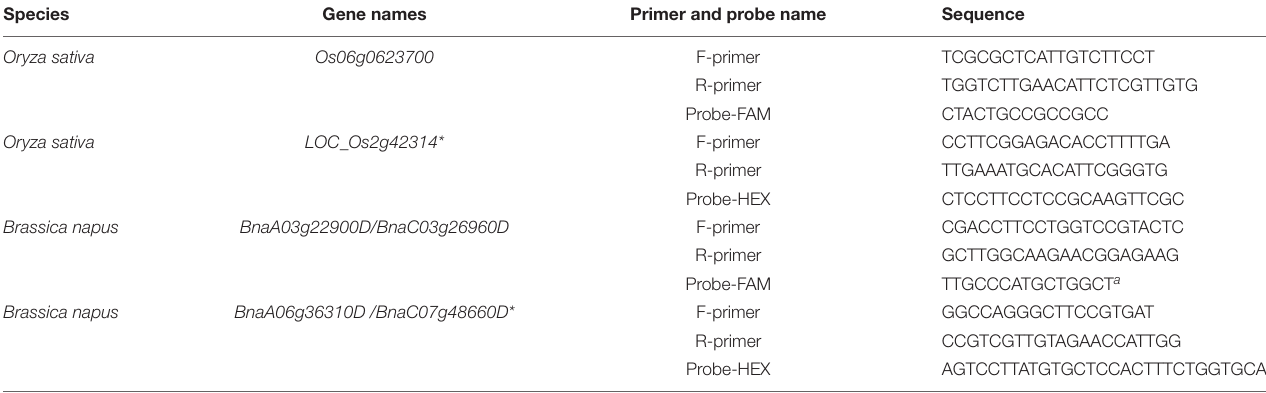
TABLE 1 | The primers and probes used in dPCR. Species